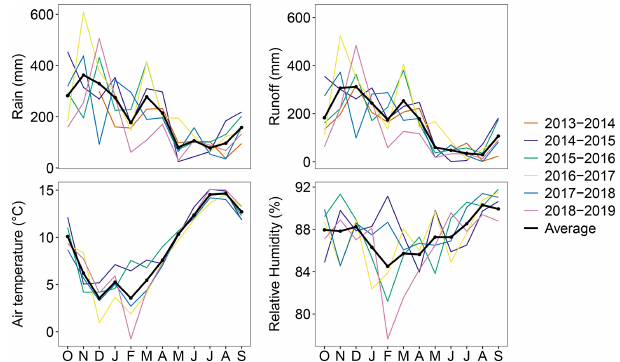
Figure 3. Seasonal rain, runoff, air temperature, and relative humidity by water year. Monthly totals (rain and runoff) and monthly averages (air temperature and relative humidity) from sta- tion SSN708 are shown, as it is the station with the longest record (installed September 2013;